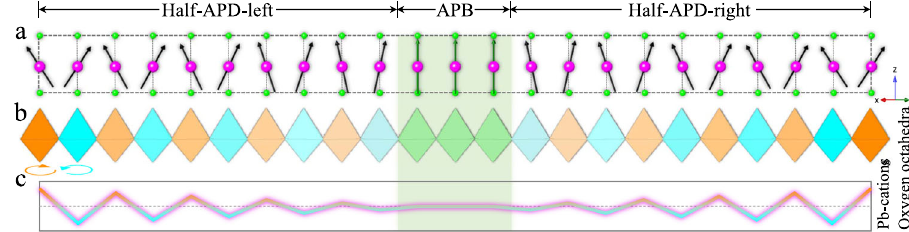
Fig. 5 The ideal atomic representative model for a larger scale picture of IP state. a Pb displacements represented by arrows vary across an APB. Pb displacements without horizontal components in APB are highlighted by green arrows. b Oxygen octahedral tilts represented by gradation of color vary across an APB. Oxygen octahedral tilts with zero value in APB are highlighted by green colour. c A schematic pro fi le illustrates combination of gradient oscillation of Pb horizontal displacements and oxygen octahedra tilts across an APB.